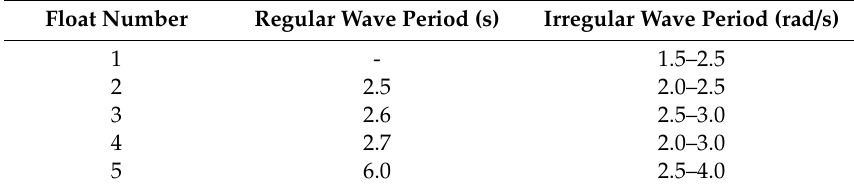
Table 1. Peak frequency